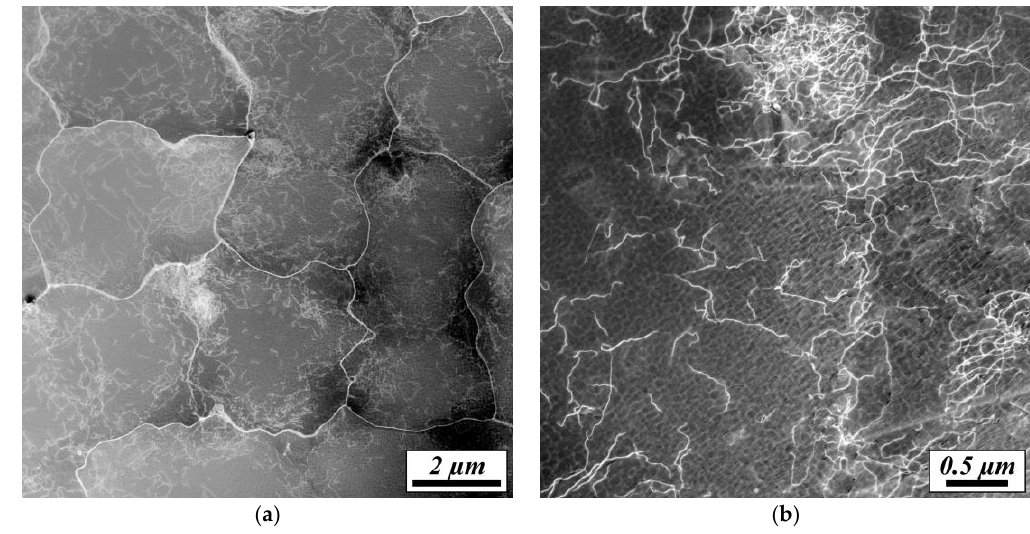
Figure 9. STEM-HAADF micrographs of the dislocation substructure in SEBM Specimen A: ( a ) overall high dislocation density, subgrain boundary network and ingrown nests of dislocations; and ( b ) ingrown dislocation nest in an interdendritic region at higher magnification.